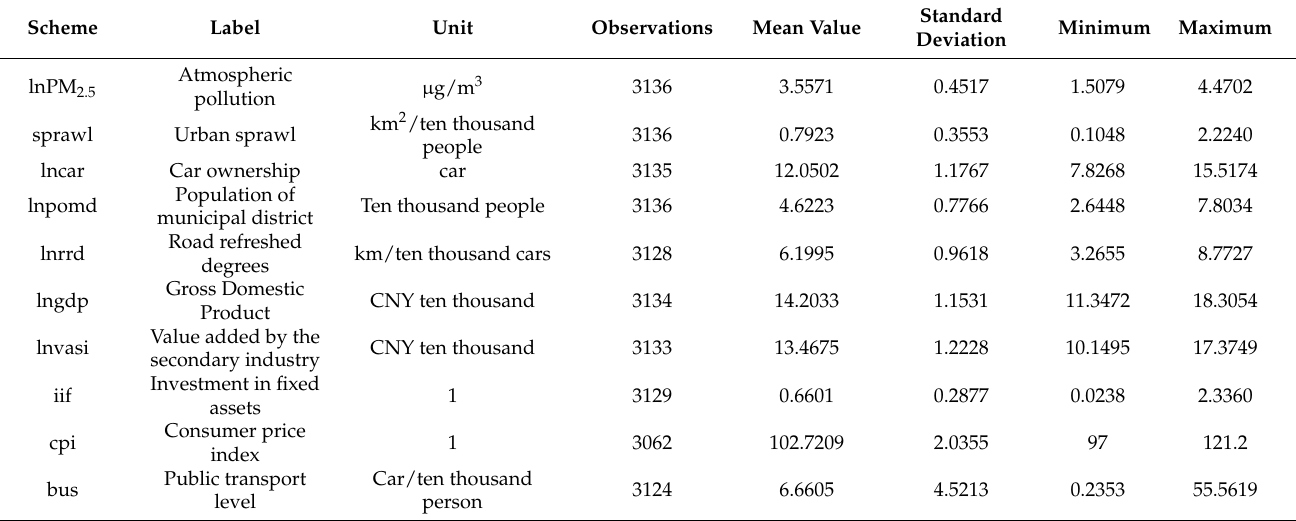
Table 1. Descriptive statistics of